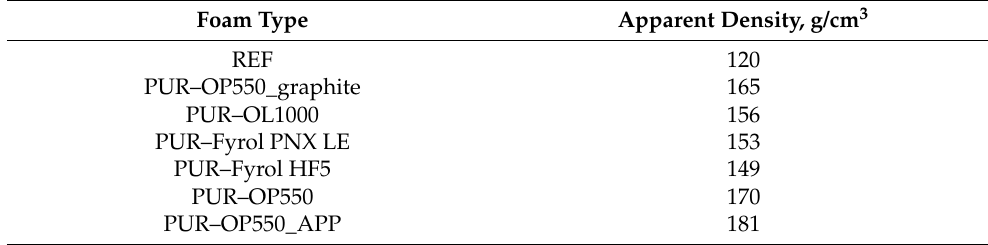
Table 3. Apparent density of foam samples by flame-retardant type.